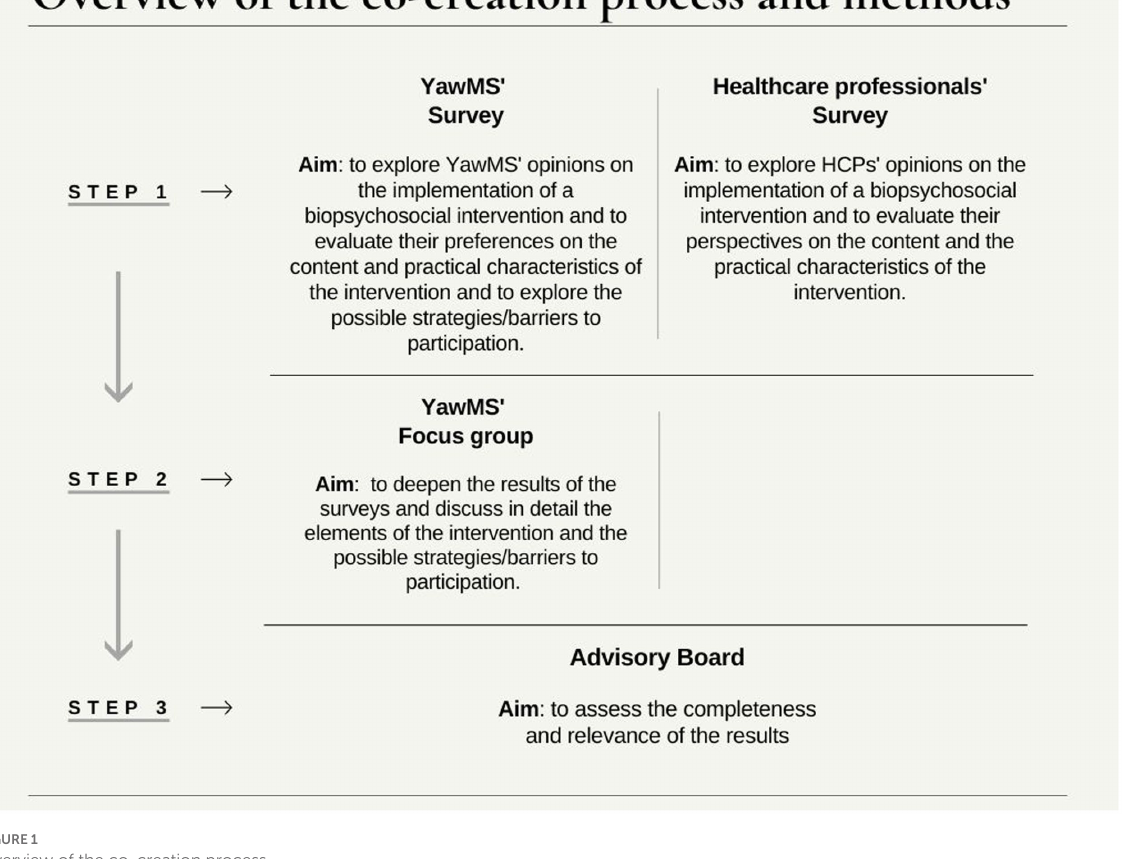
FIGURE 1 Overview of the co-creation